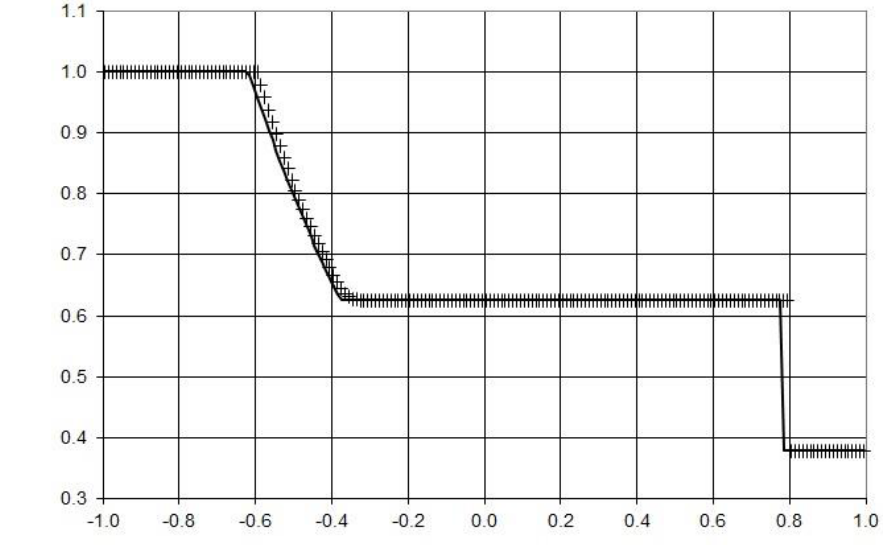
Figure 6. Velocity plot for the shock-tube problem (46) for the adiabatic gas dynamics equations: the exact solution (line), and the present method (cross).